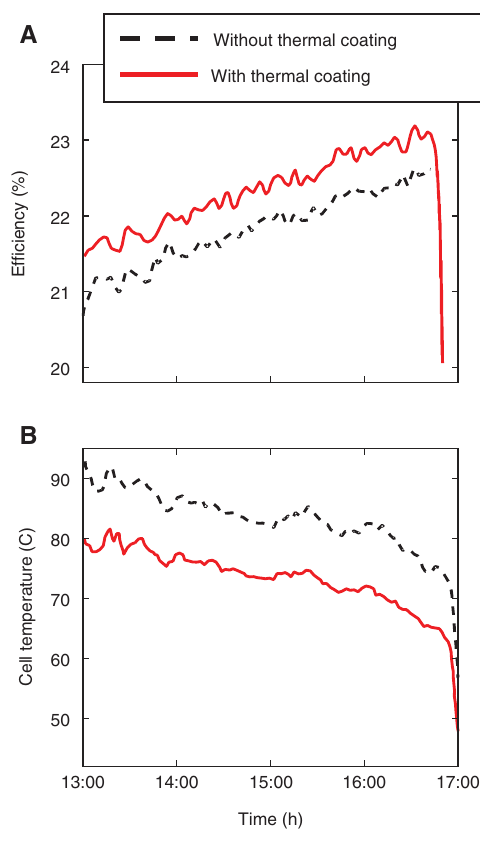
simulation framework, a temperature drop of 90 ° C of TPV cells by radiative cooling has been predicted in [64] (see Figure 11A). With sufficient cooling concentration factor (area ratio between the radiative cooling emitter and the